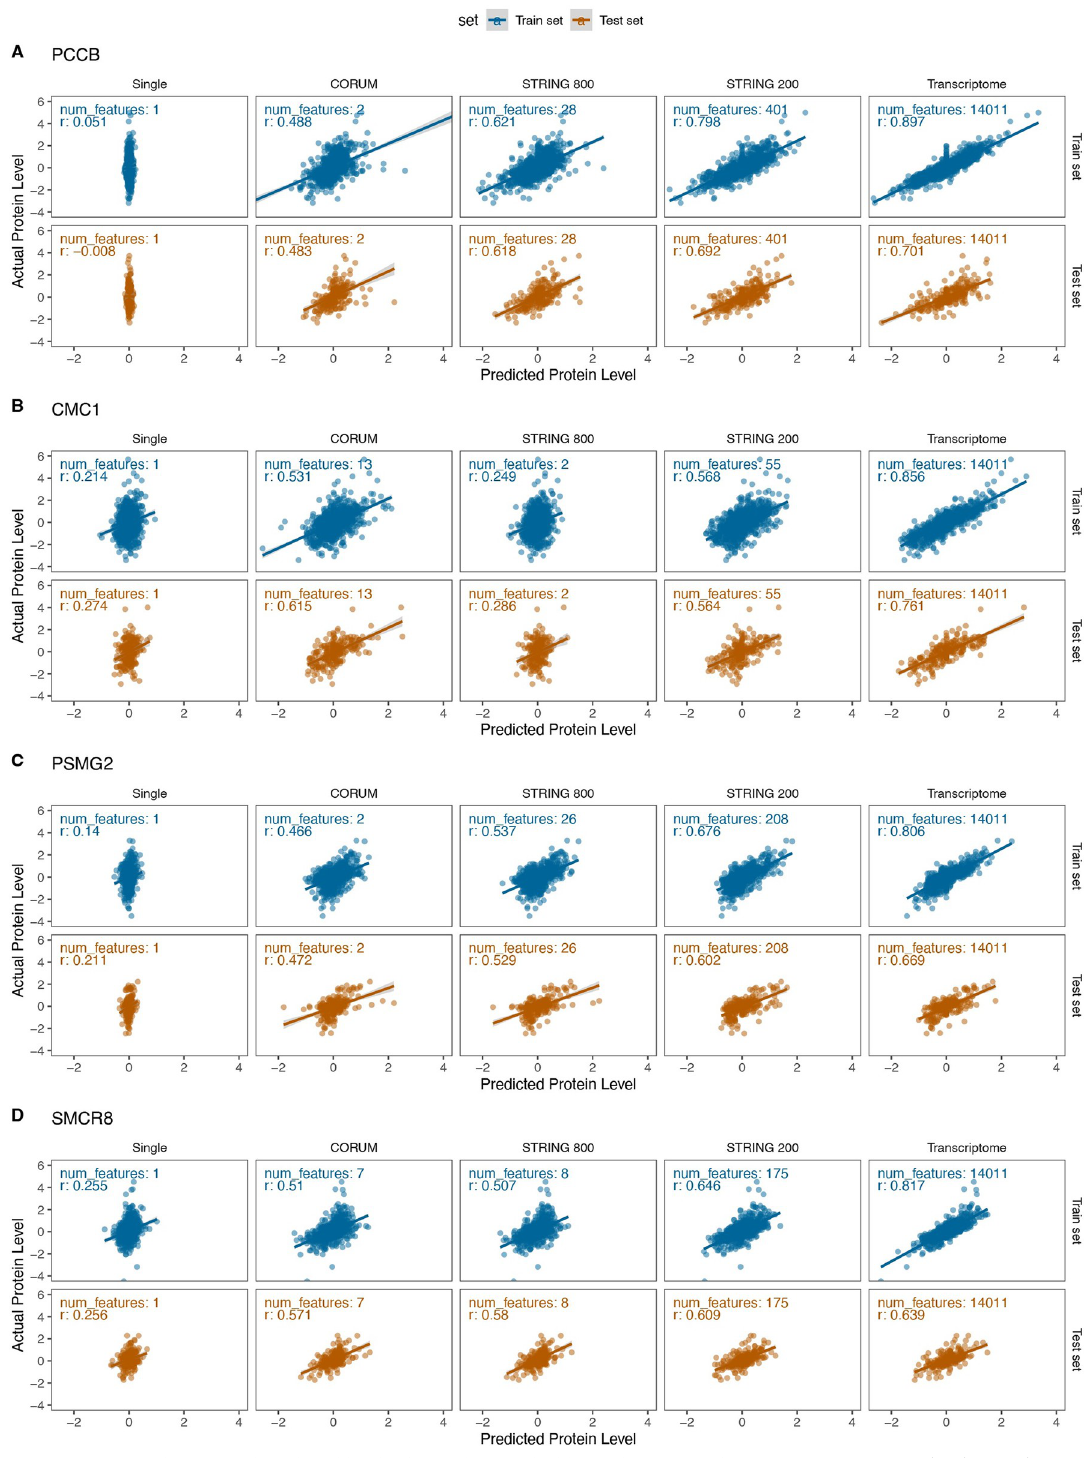
Fig 3. Proteins with improved predicted levels after inclusion of additional transcript features. Four proteins with substantial predictability from transcriptome data upon the inclusion of additional features are shown: A. PCCB, B. CMC1, C. PSMG2, D. SMCR8. For each protein, the transcript-trained prediction of protein level is plotted on the x axis and the actual protein level is plotted on the y axis. The lack of variance in predicted protein levels from the self-transcript model is due to the regularization of the elastic net model, and corresponds to a lack of correlation between PCCB mRNA and protein (see Fig 4). Blue: train set, brown: test set. Columns